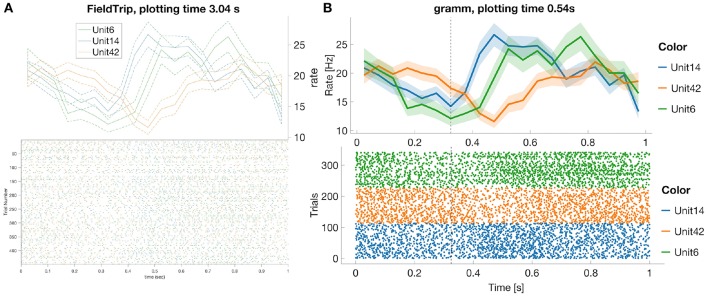
FieldTrip (A) and gramm (B) provide most adjustable peri-stimulus (PSTH) and raster plots properties (plotting time is averaged over 1,000 runs, MATLAB 2016a, here and later for processor 3.2 GHz Intel Core i5 with 16 GB RAM) among toolboxes from Table 3. We considered 50 ms bin size, M1 units 6, 14, 42, monkey MM for the test dataset. PSTHs are presented with standard error of the mean, neural activity is aligned to trial start for reaches toward the second target in the trial. FieldTrip build-in tools do not allow to adjust font size in a raster plot and line width in a PSTH plot (one has to do it manually with MATLAB tools), and do not allow to plot raster and PSTH in separate figures (though one can plot spike densities in a separate figure). Advantages of gramm toolbox for PSTH and raster plots are quick plotting, raster plots separation for different units, vertical dashed lines for showing event times of the experiment protocol, and smooth adjustment of line width, font size, color maps, errorbar, components positions, etc.